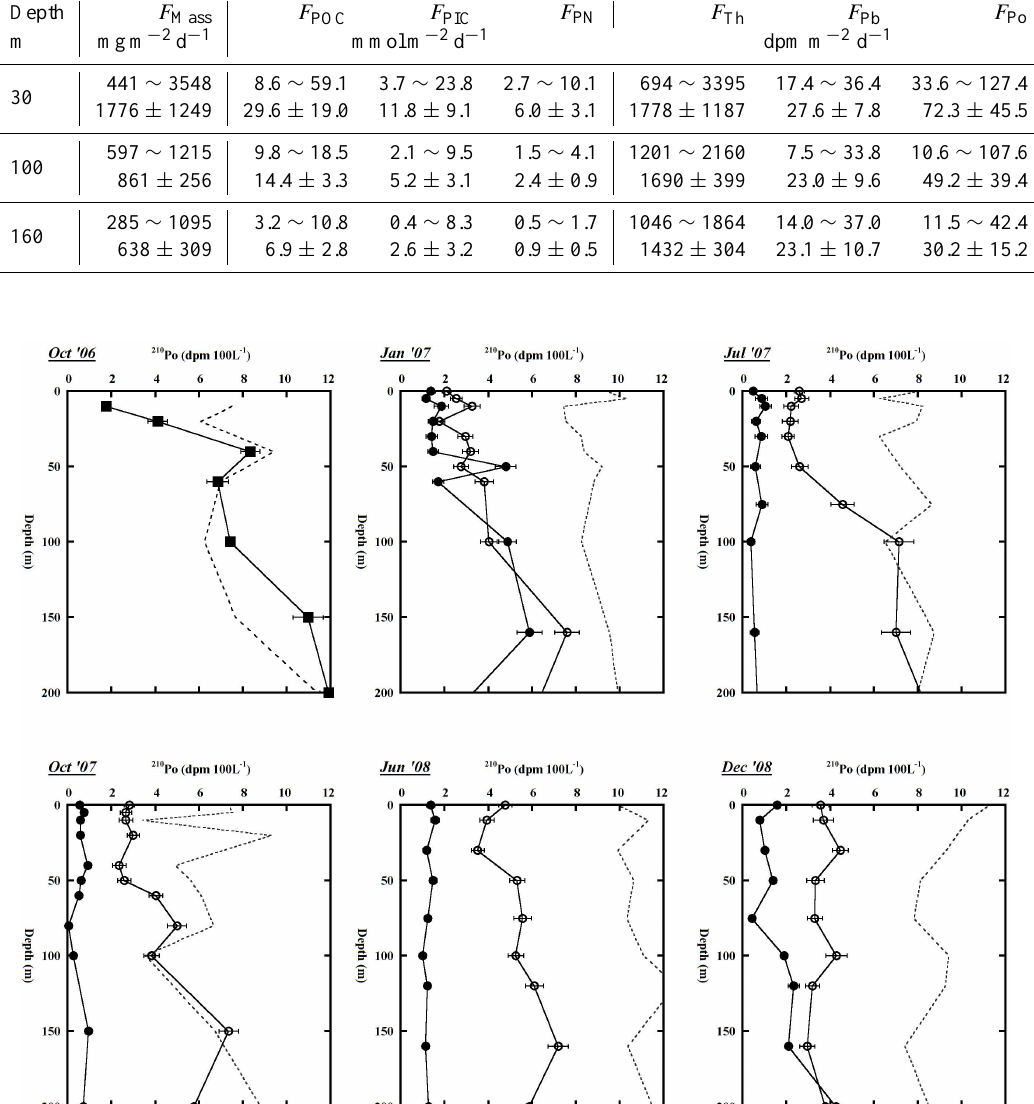
210 Pb 210 Po (solid triangle) is available for ORI-821 p . Note only total d and